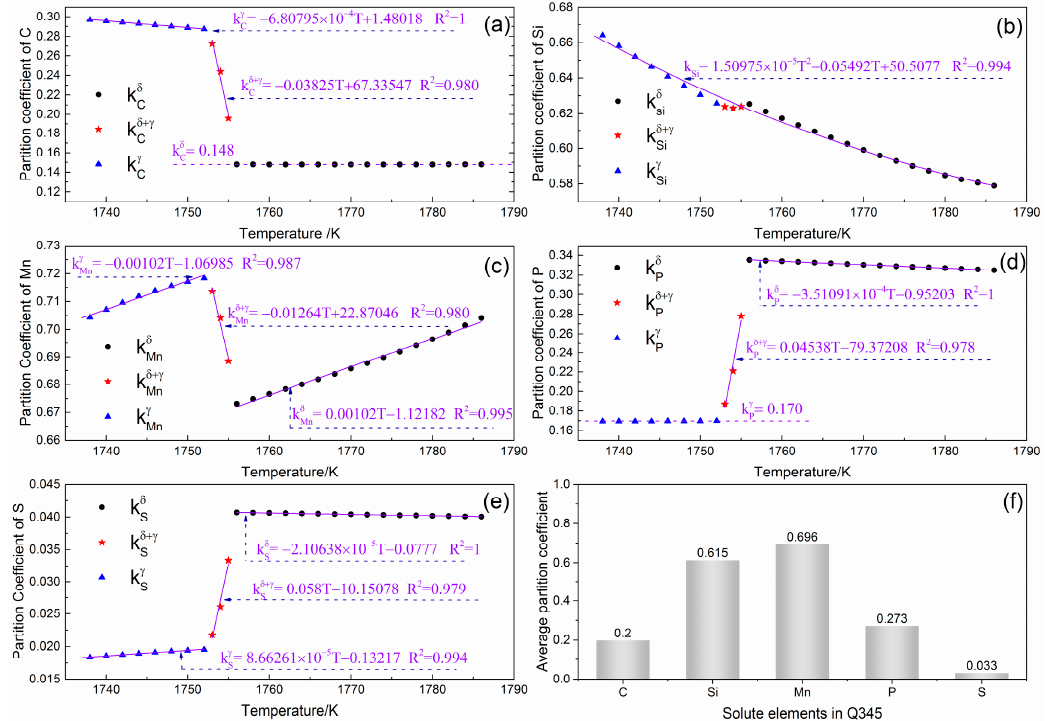
Figure 5. Evalution of ( a ) k C , ( b ) k Si , ( c ) k Mn , ( d ) k P , ( e ) k S , and ( f ) average equilibrium partition coefficients of solutes during peritectic steel Q345 solidification.